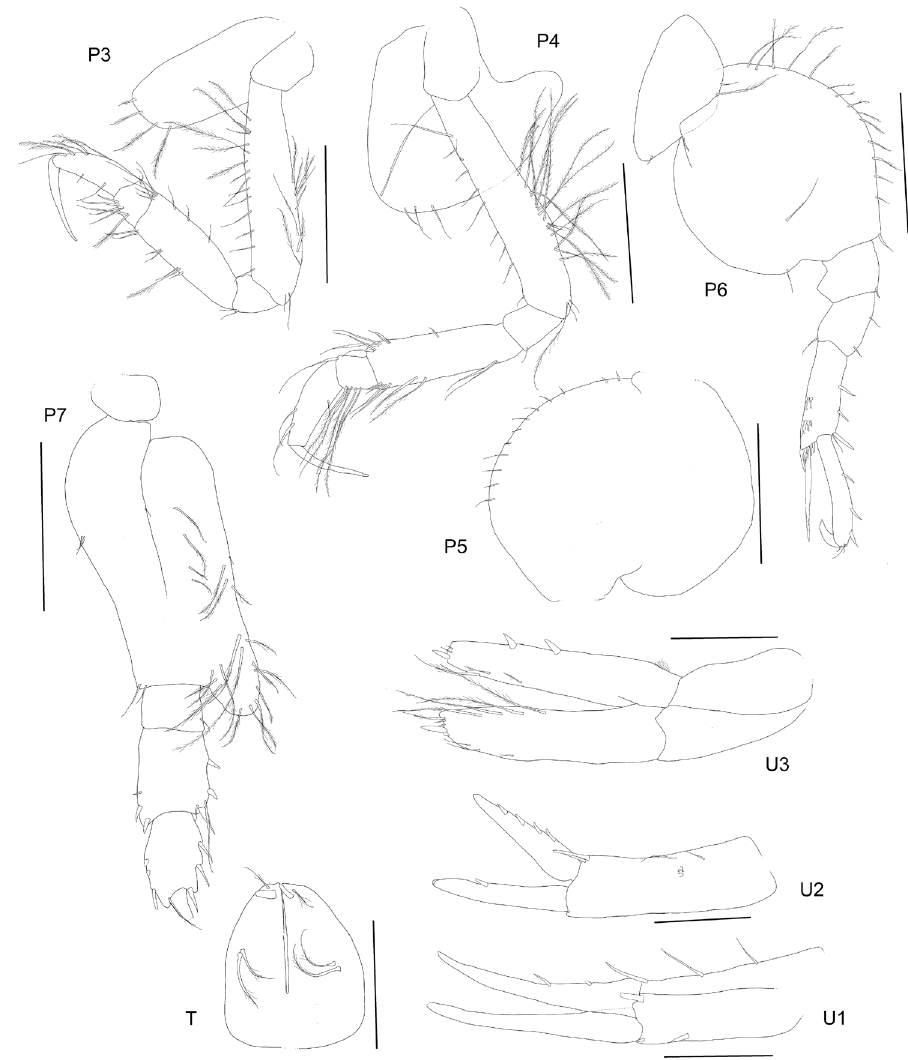
Figure 7. Haploops dauvini sp. n., holotype, female, 7 mm, ZMH K-47038, Norwegian Channel, 587.4– 614.4 m. Pereopods 3–7 scales represent 0.5 mm. Uropods 1–3 and Telson scales represent 0.2 posterior lobe; merus same length as ischium, weakly setose; carpus longer than merus, slightly shorter than propodus (0.85 × not including posterior lobe), anterior margin with two weak robust setae, posterior margin with two rows of stout robust setae (2 and 4), and extended to form a lobe bearing 6 strong, robust setae increasing in length laterally; propodus narrower than carpus, anterior margin with two weak robust setae, posterior margin without robust setae, anterior margin produced slightly to form a